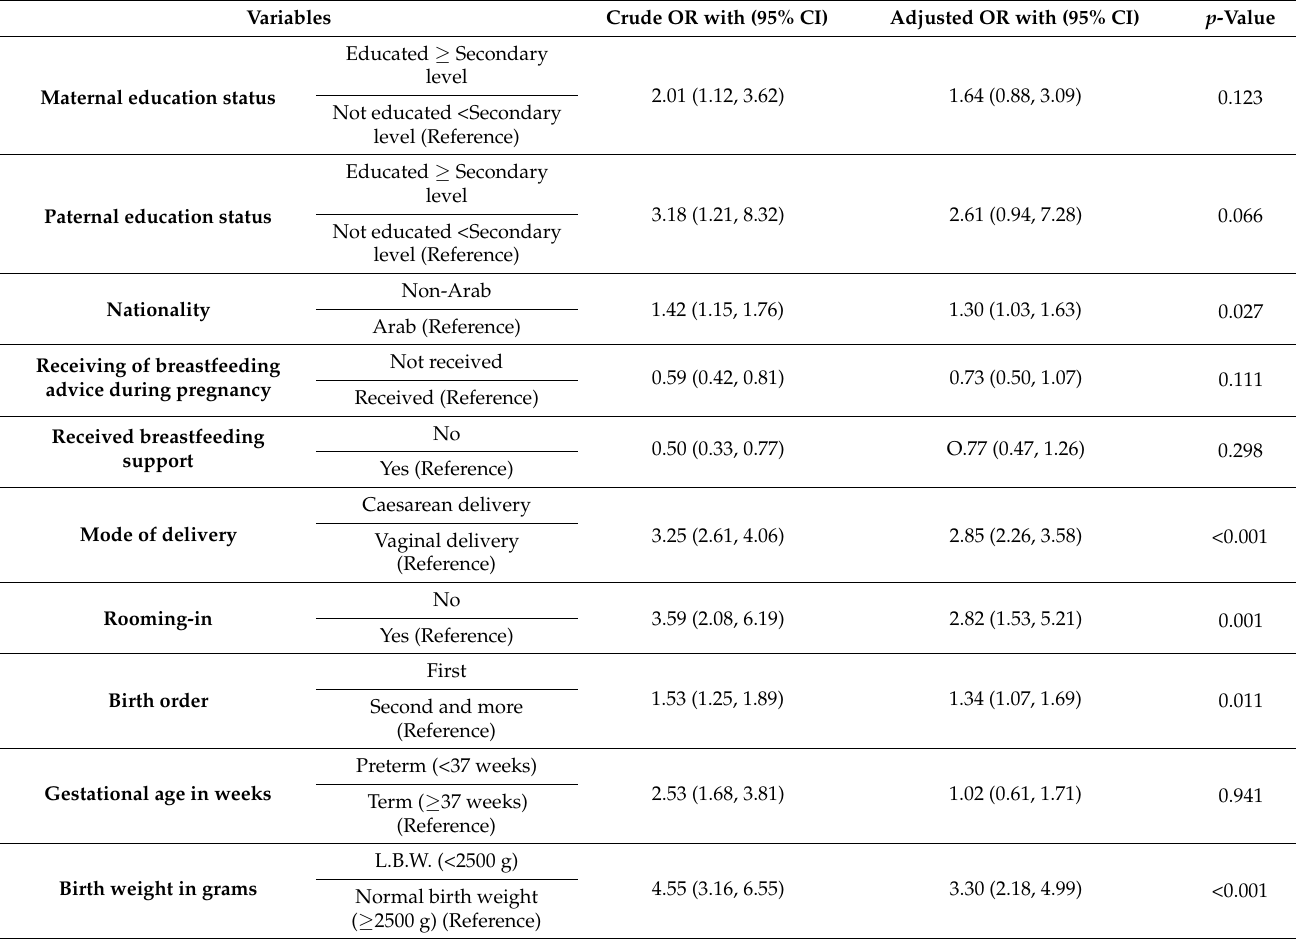
Table 3. Factors associated with delayed initiation of breastfeeding among mothers with children less than 2 years old in Abu Dhabi, the U.A.E. by using logistic regression. Variables Crude OR with (95% CI) Adjusted OR with (95%